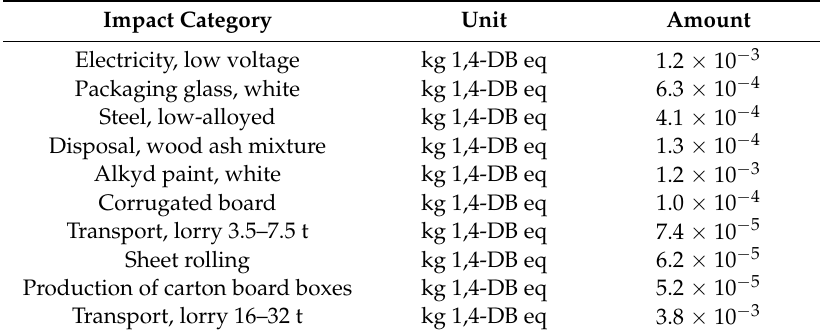
Table 4. Characterisation results for marine ecotoxicity—first ten processes (30% assumption—extracted from SimaPro (Pr é 2018)).